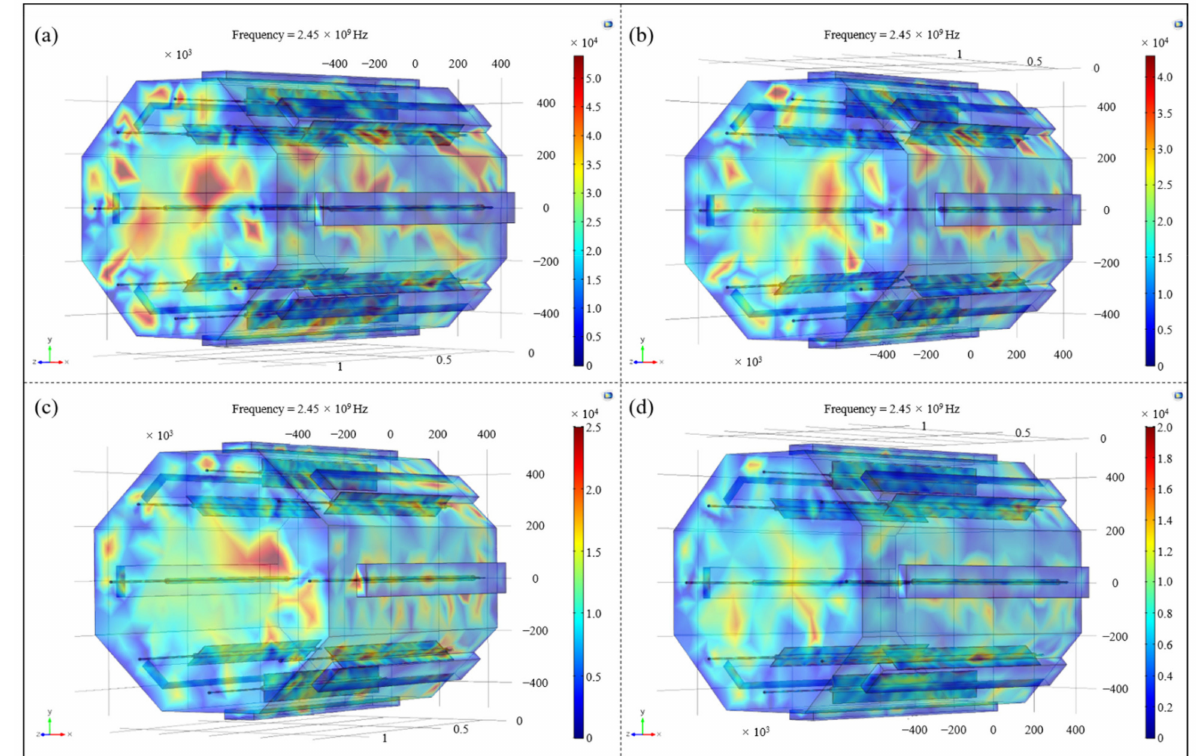
Figure 8. The spatial electric field nephograms under different arrangements of microwave generators: ( a ) number (6); ( b ) number (9); ( c ) number (16); ( d ) number